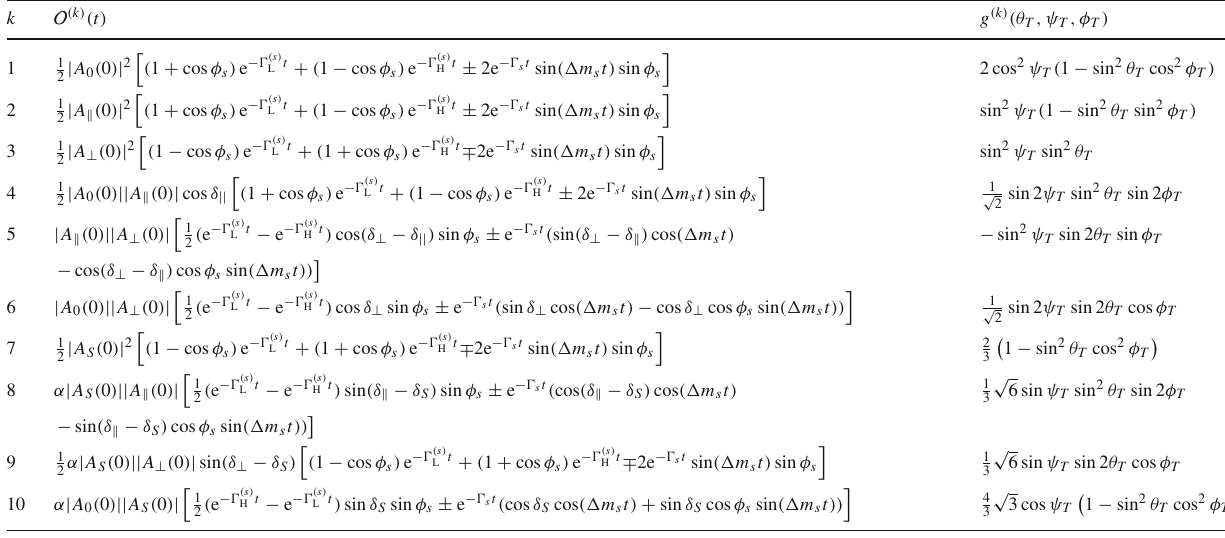
wave amplitude | A S ( 0 ) | 2 gives the fraction of B 0 s → J /ψ K + K − ( f 0 ) and has a related strong phase δ S . The factor α is described in the text of Sect. 5.1. The ± and ∓ terms denote two cases: the upper sign describes the decay of a meson that was initially a B 0 s meson, while the lower sign describes the decays of a meson that was initially ¯ B 0 s